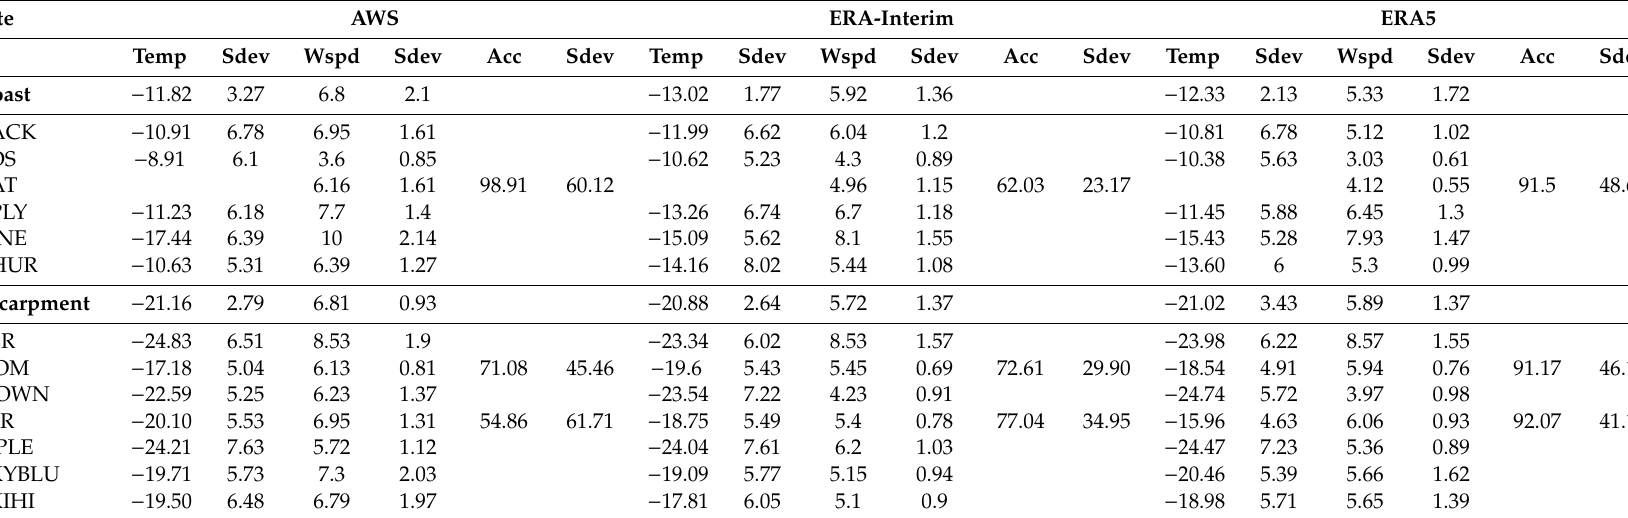
Table 2. Summary of the statistics of meteorological parameters from AWS and climate reanalyses. Temp: mean surface air temperature ( ◦ C), Wspd: mean